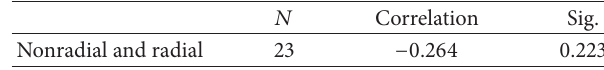
Table 11: Paired samples correlations. 𝑁